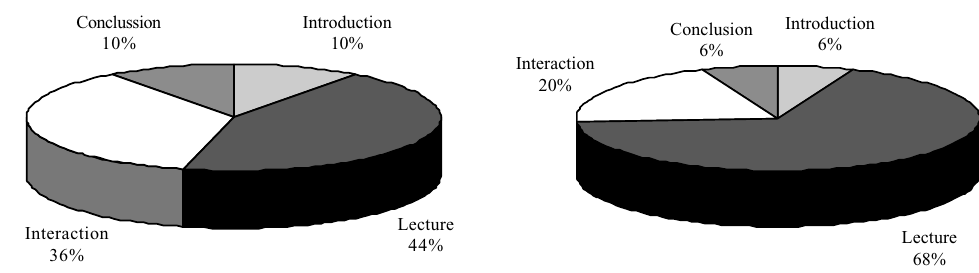
Figure 2. Typical time allocation for traditional lectures compared with EVS-interactive style